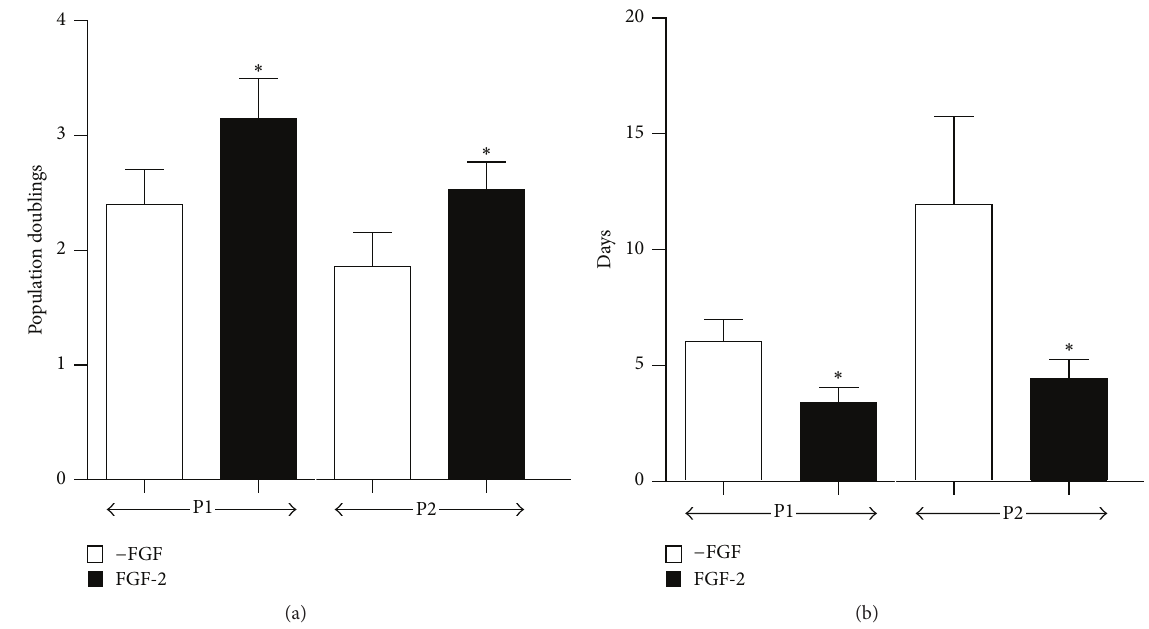
Figure 1: Effect of FGF-2 supplementation on SF-CP proliferation. (a) Population doublings and (b) population doubling (PD) times, during the first (P1) and second (P2) passages, in the absence (white bars) or presence (black bars) of FGF-2 (mean ± SD; 𝑛 = 15 ). In both figures, asterisks indicate significant differences between the control and FGF-treated cultures at each